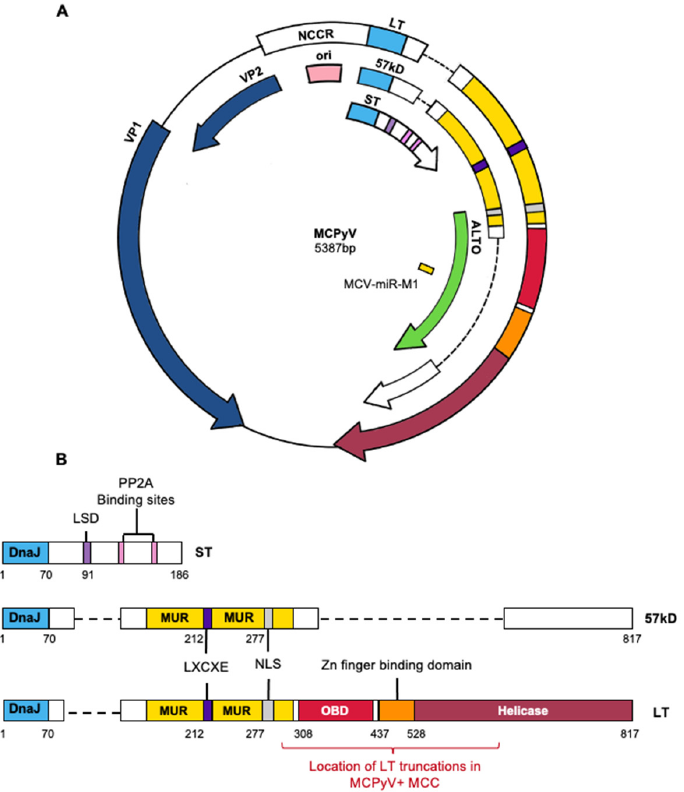
Figure 1. MCPyV genome and T antigens. ( A ) Circularized MCPyV viral genome depicting NCCR, early genes (ST, 57kD, LT, ALTO), late genes (VP1, VP2) and the microRNA miR-m1. Abbreviations: ST—small tumor antigen, 57kD—57 kD tumor antigen, LT—large tumor antigen,